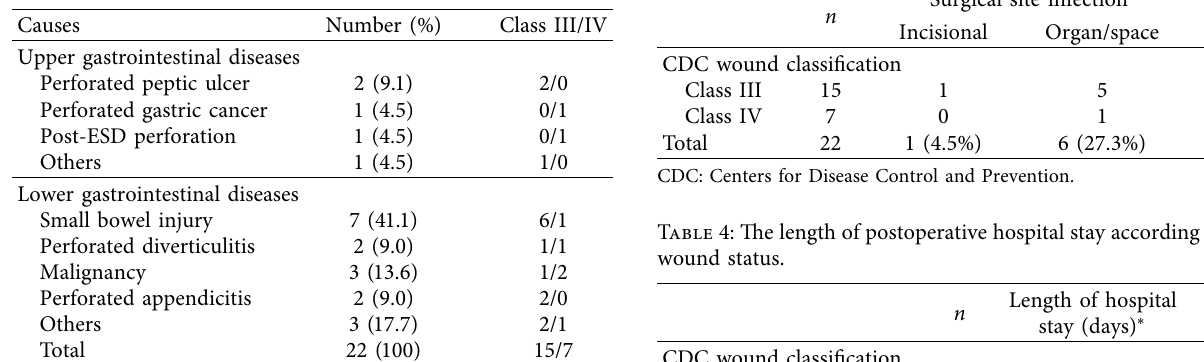
Table 3: Surgical site infection and CDC wound classifcation.